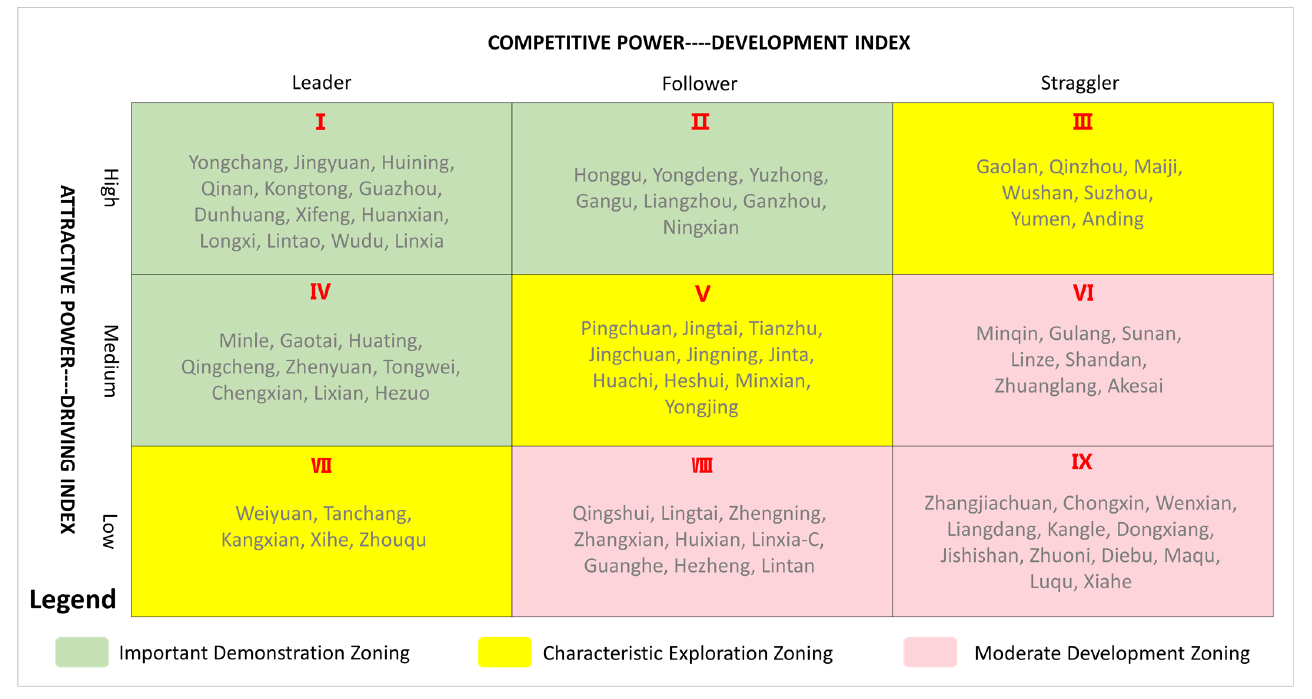
Figure 10. Analysis on spatial zoning of village economy digitalization in Gansu.